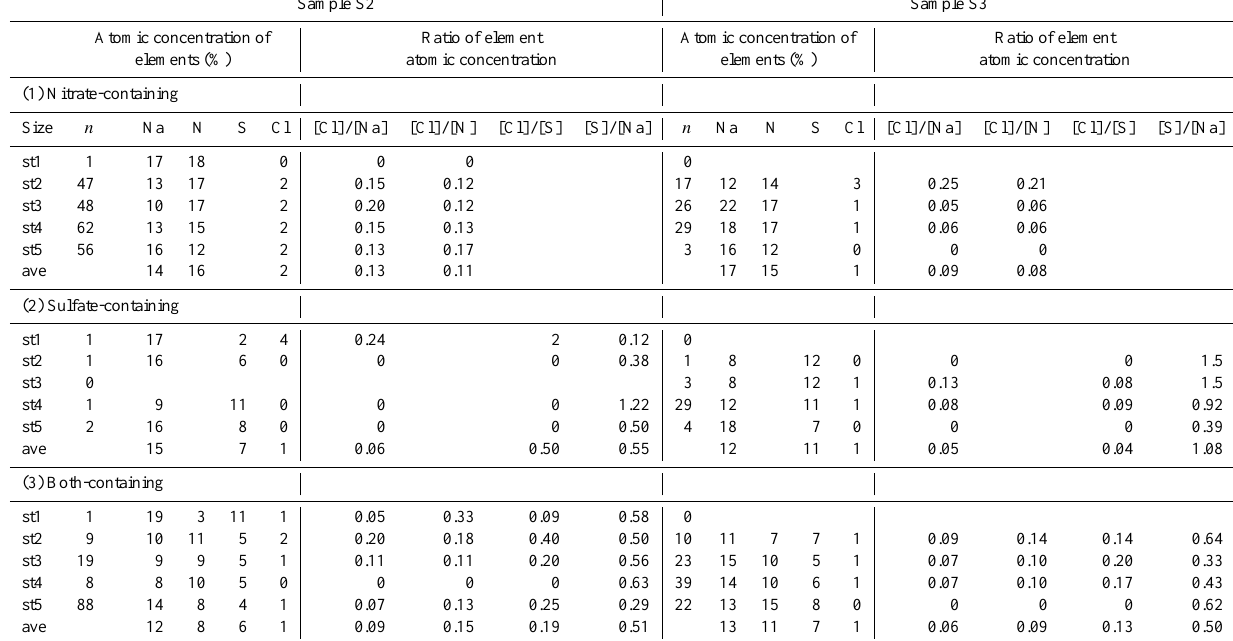
Table 6. The concentrations of elements Na, N, S, and Cl and their ratios in the reacted SSAs at different stages in samples S2 and S3. Sample S2 Sample S3 Atomic concentration of Ratio of element Atomic concentration of Ratio of element elements (%) atomic concentration elements